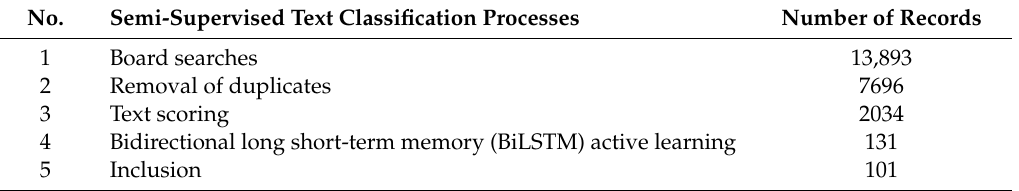
Table 2. Number of records derived from each step of semi-supervised text classification.